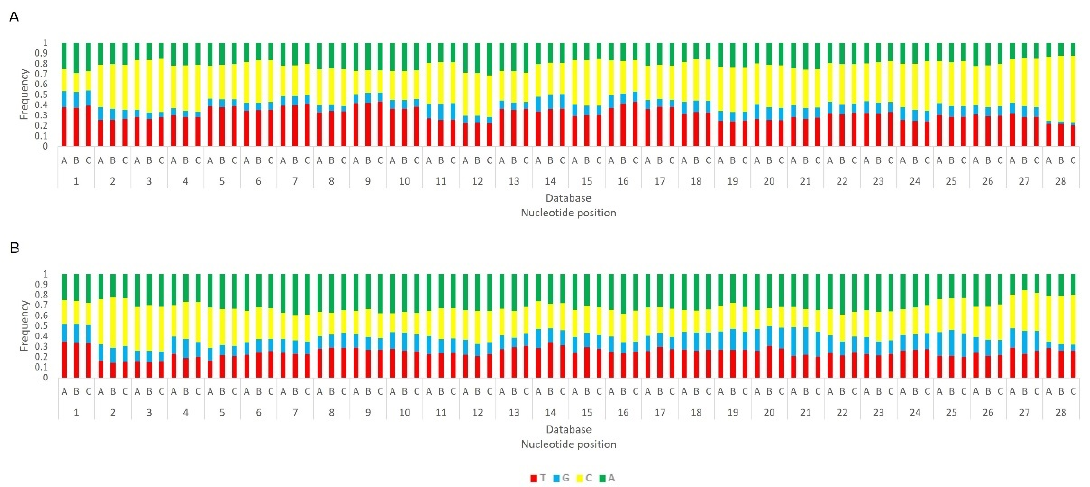
Figure 8. Distribution of BmN4 sRNAs mapping to S. frugiperda Rhabdovirus (RV). Left: distribution of sRNAs 19–21 nt-long. Right: distribution of sRNAs 26–29 nt-long. White bars: sense reads. Black bars: anti-sense reads. A–E: represented databases, listed in Table S2. Pink: nucleoprotein ORF; brown: phosphoprotein ORF; purple: matrix protein ORF; yellow: glycoprotein ORF; green: accessory protein of unknown function ORF; red: RdRp ORF.